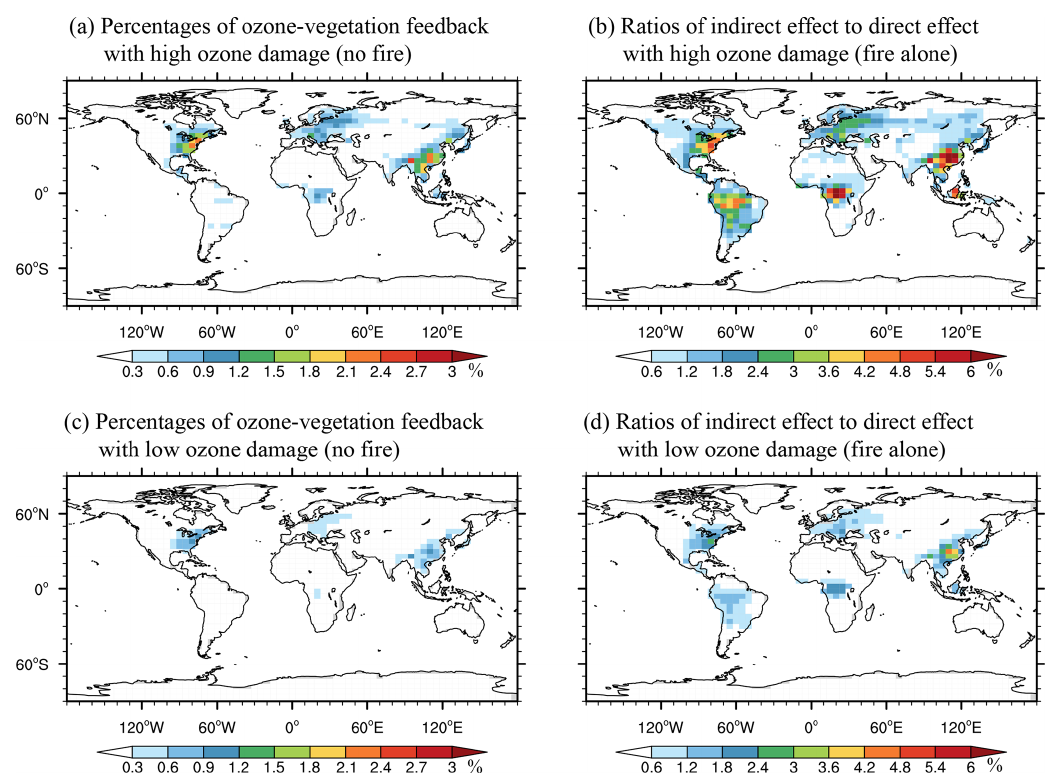
Figure 7. Annal ratios of indirect (cid:49) [O 3 ] to ambient [O 3 ] from (a, c) non-fire emissions and the ratios of indirect to direct (cid:49) [O 3 ] from (b, d) fire emissions alone with (a, b) high and (c, d) low O 3 -damaging sensitivities. Please note the differences in color scales.